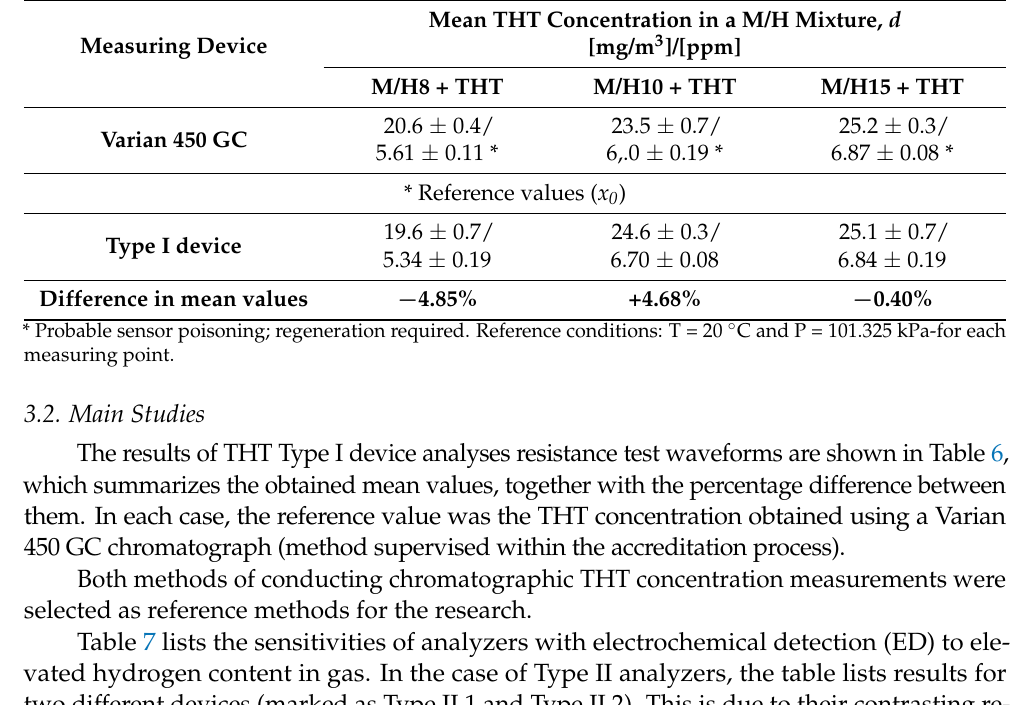
Table 5. List of test results regarding the sensitivity of a Type IV electrochemical sensor on methane/hydrogen